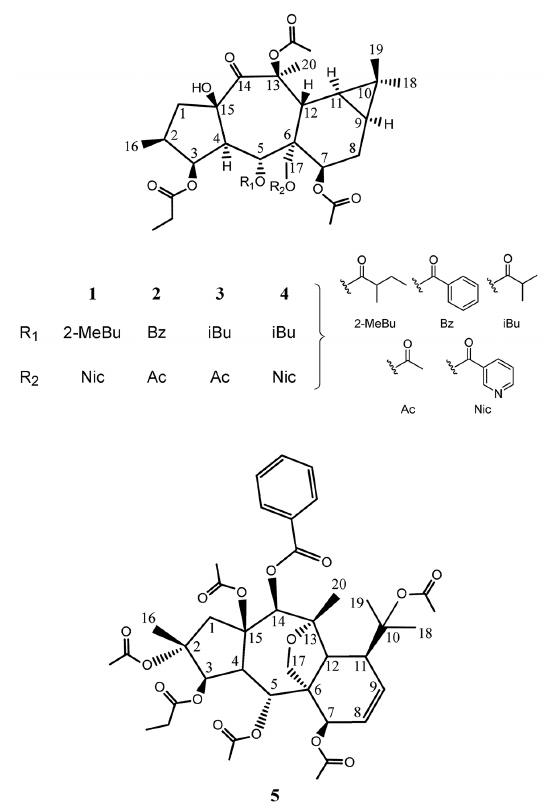
Figure 2. Premyrsinanes ( 1 – 4 ), and myrsinane diterpene ( 5 ) from Euphorbia gedrosiaca. Compound 1 , isolated with optical rotation of +16.4 (c 0.14 EtOAc), was established as C 38 H 51 NO 12 (HR-ESIMS m/z 736 [M+Na] + ; calcd 736, Δ = 3.1 ppm). Resonances at δ C 165.0, 128.1, 150.7 ( δ H : 9.16, d, J = 2.0 Hz), 136.9 ( δ H : 8.19, dt, J = 8.0, 2.0 Hz), 123.8 ( δ H : 7.44 (dd, J = 8.0, 5.0 Hz), 154.1 ( δ H : 8.82, bd, J = 5.2, 1.6 Hz) belong to the nicotinoyl group at C-15 and